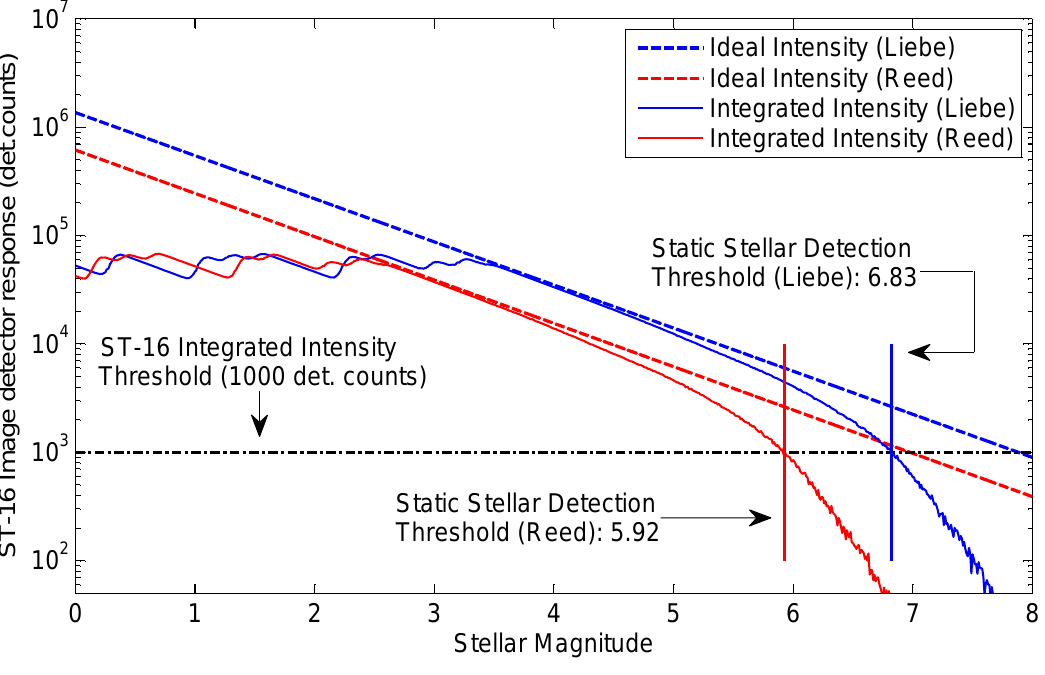
Figure 7. Comparing star tracker sensitivity